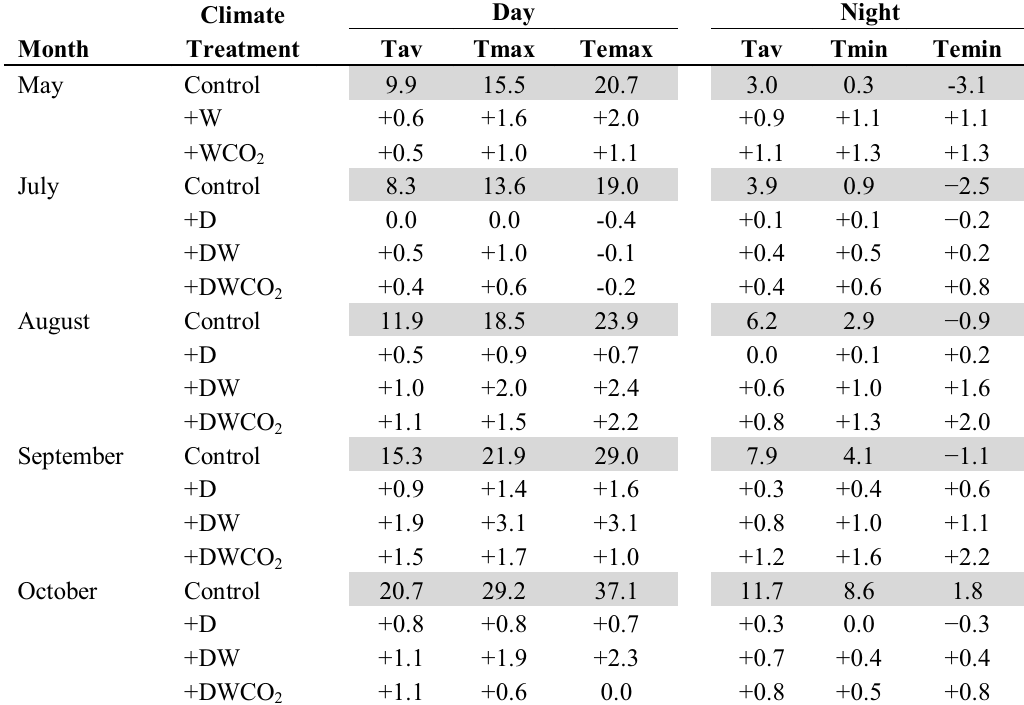
Figure 3. Tav = average temperature, Tmax = average daytime maximum, Temax = extreme (highest) daytime maximum, Tmin = average night minimum, Temin = extreme (lowest) night